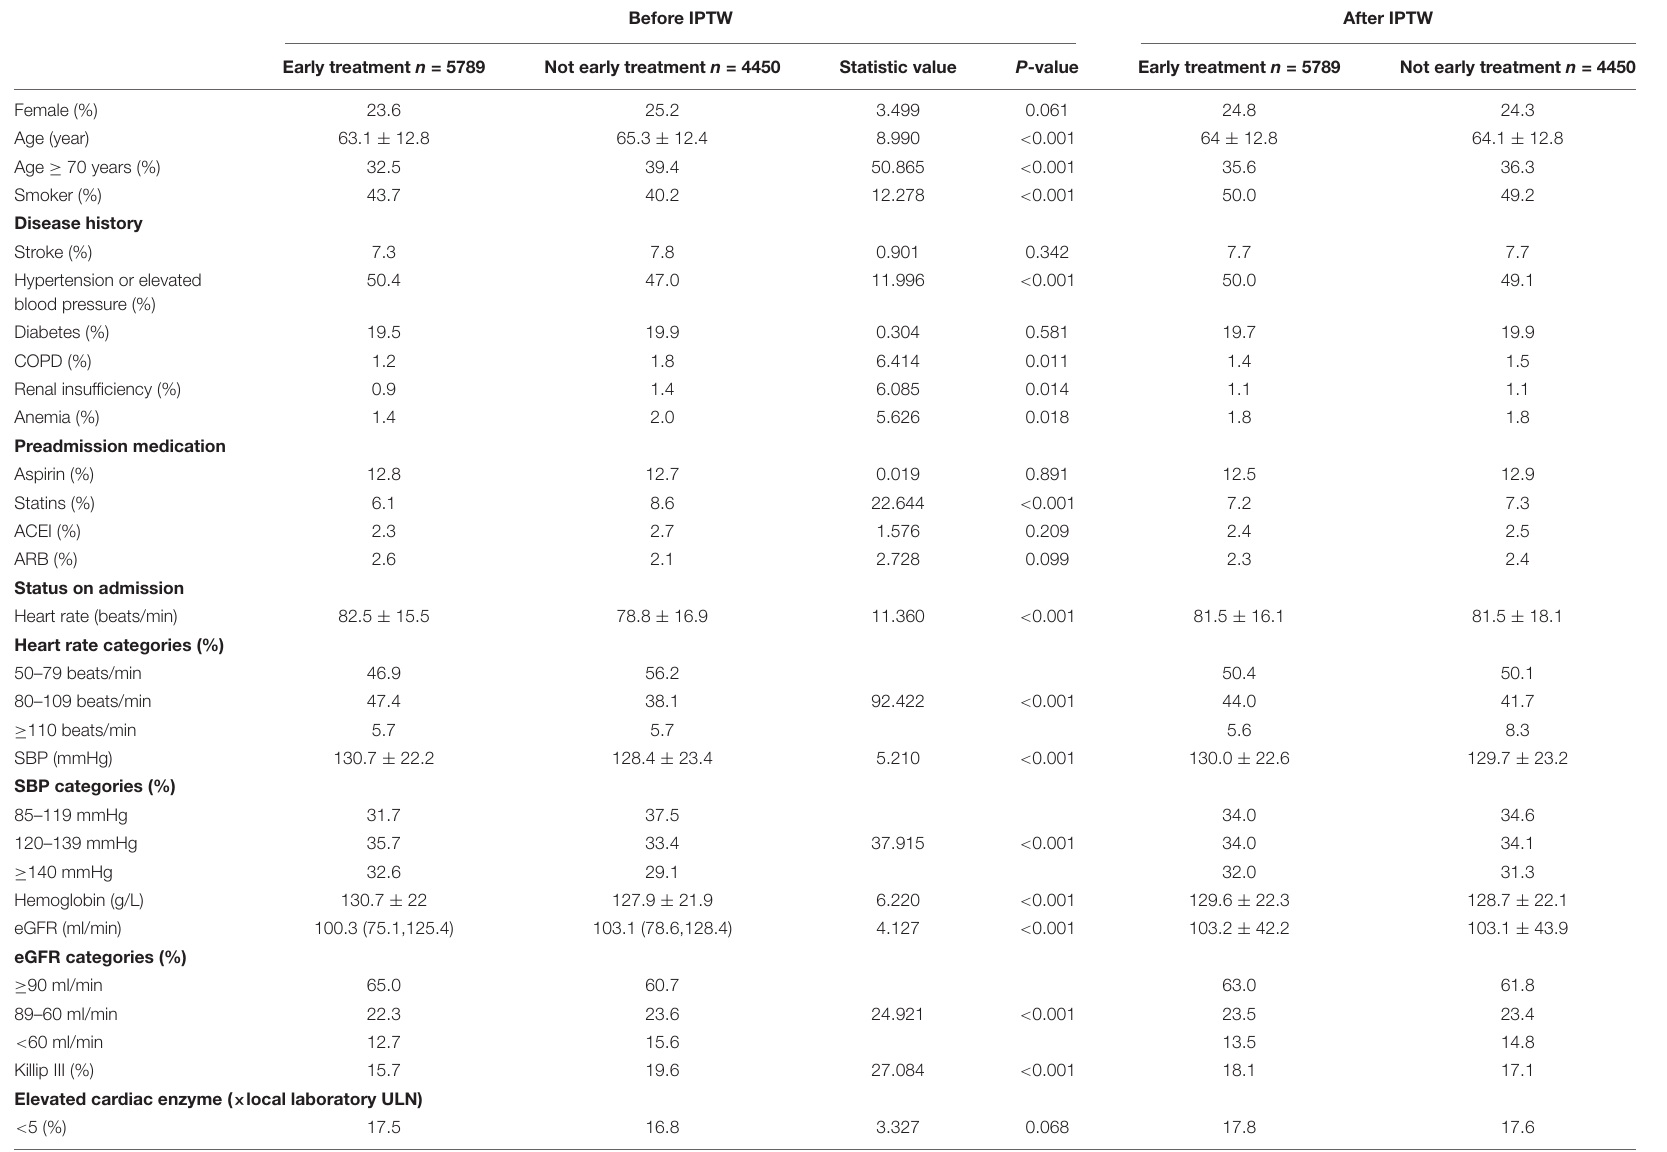
TABLE 1 | Characteristics of patients with and without early oral β -blocker